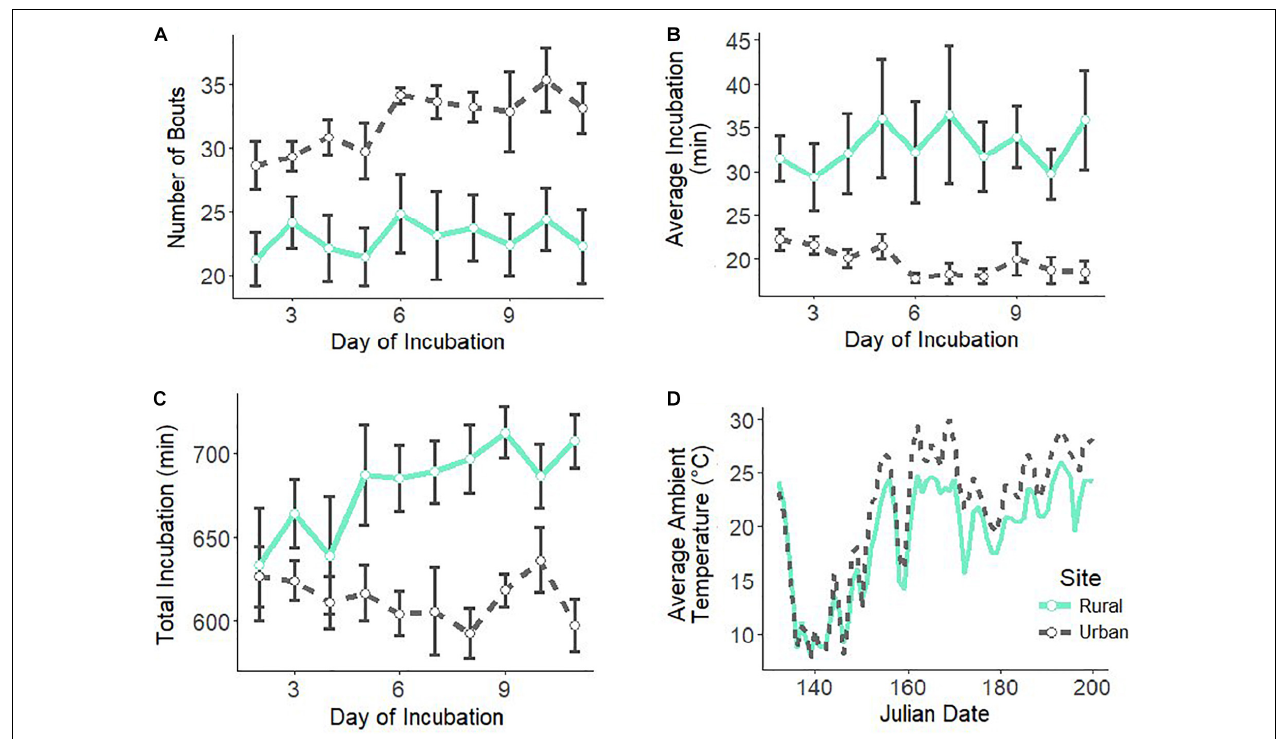
FIGURE 1 | Female house wren incubation behaviors over the 11 days of incubation, including number of incubation bouts (A) , average incubation bout duration (B) , and total incubation duration (C) . Ambient daytime temperatures are shown for both sites throughout the breeding season (D) . Urban site and females are in black, dotted lines and rural site and females are in green, solid lines. Shown are means ± 1 SE.